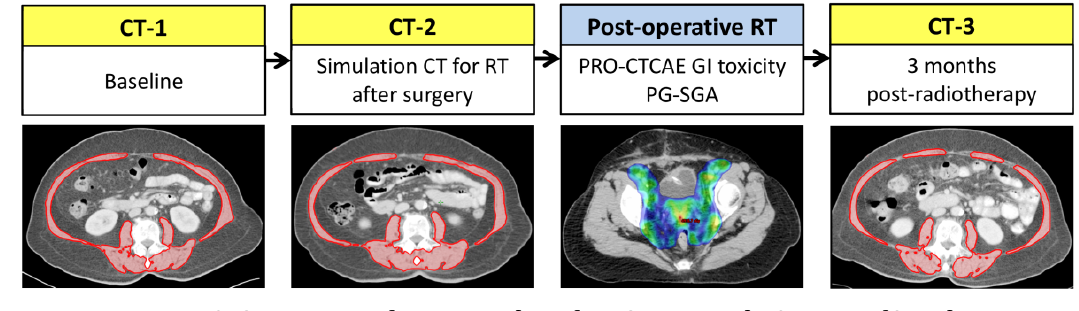
Figure 1. Scheme of CT scans for patients with cervical or endometrial cancer receiving surgery and post-operative pelvic radiotherapy. Skeletal muscle area (red) was measured on a CT slice at the L3 vertebral level. RT, radiotherapy.